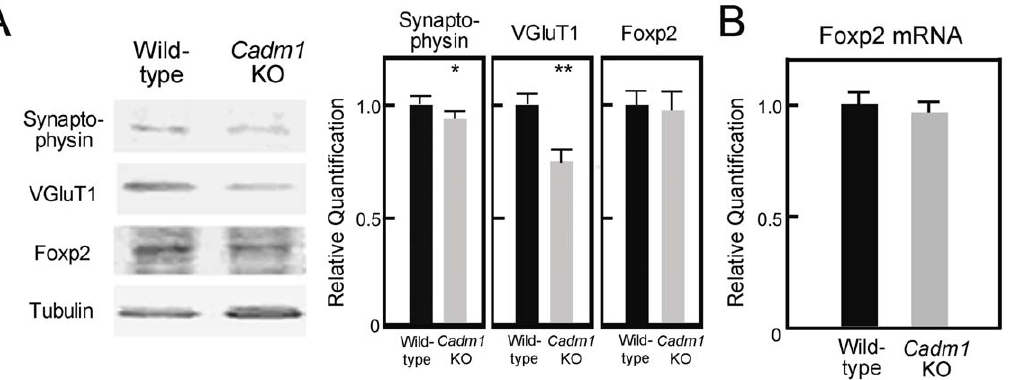
Figure 5. The influence of Cadm1 deficiency on the expression of synaptic proteins and Foxp2 in the cerebellum. (A) Immunoblot analysis of the influence of the deficiency in the cerebellums of Cadm1 KO and wild-type pups (P10). An example of the typical immunoblotting results is shown. Values are mean 6 standard error (SEM). Student’s t -test (* p , 0.05, ** p , 0.01). Pups: n=5. All experiments were performed three times. (B) RT-PCR analysis of the influence of the Cadm1 deficiency on the expression of Foxp2 in the cerebellum of wild-type and Cadm1 KO pups (P10). Values are mean 6 standard error (SEM). Pups: n=5. All experiments were performed three times. A comparison showed no significant difference (Student’s t -test; p , 0.05).